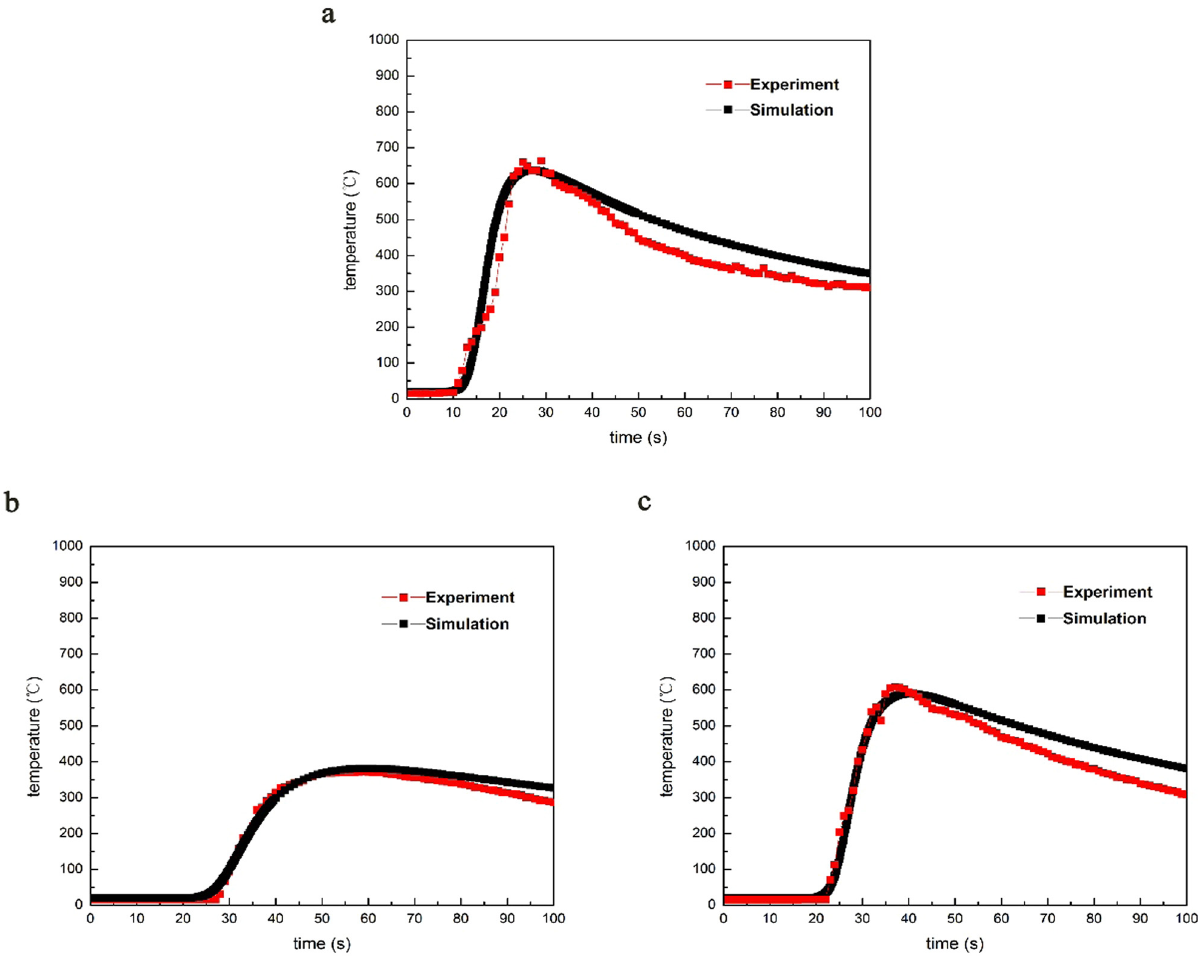
Figure 6: Comparison of experimental and simulated temperature histories in GTAW process: ( a ) point A; ( b ) point B and ( c ) point